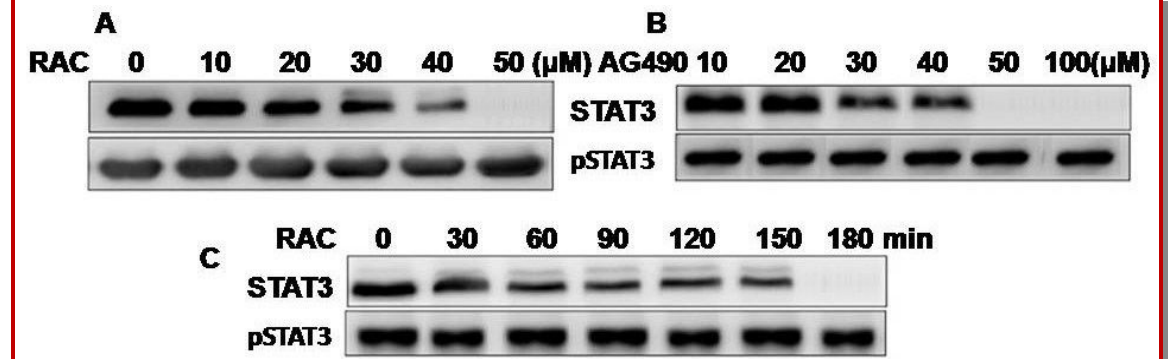
Figure 3: Effect of 2-florobenzaldehyde retinoic acid conjugate and AG490 on activation of STAT3 in U373 cells. (A) 2- florobenzaldehyde retinoic acid conjugate inhibited phospho-STAT3 levels in a dose-dependent manner in U373 cells. (B) AG490 inhibited activation of STAT3 phosphorylation in U373 cells after 8 hours. (C) 2-florobenzaldehyde retinoic acid conju- gate suppresses phospho-STAT3 levels in U373 cells in 3 hours